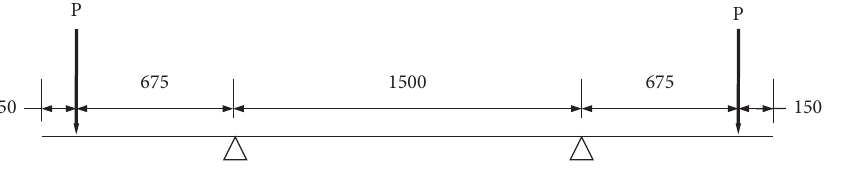
Figure 8: Force diagram of the upper reaction